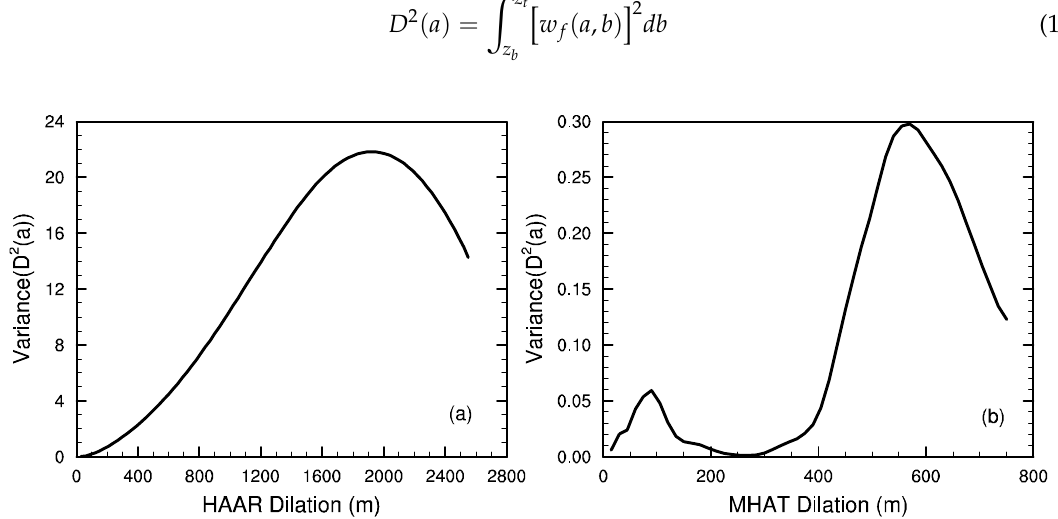
Figure 6. The wavelet variance, D 2 ( a ) , of HAAR ( a ) and MHAT ( b ) as described in Equation (13), for the RSCS profile in Figure 5.